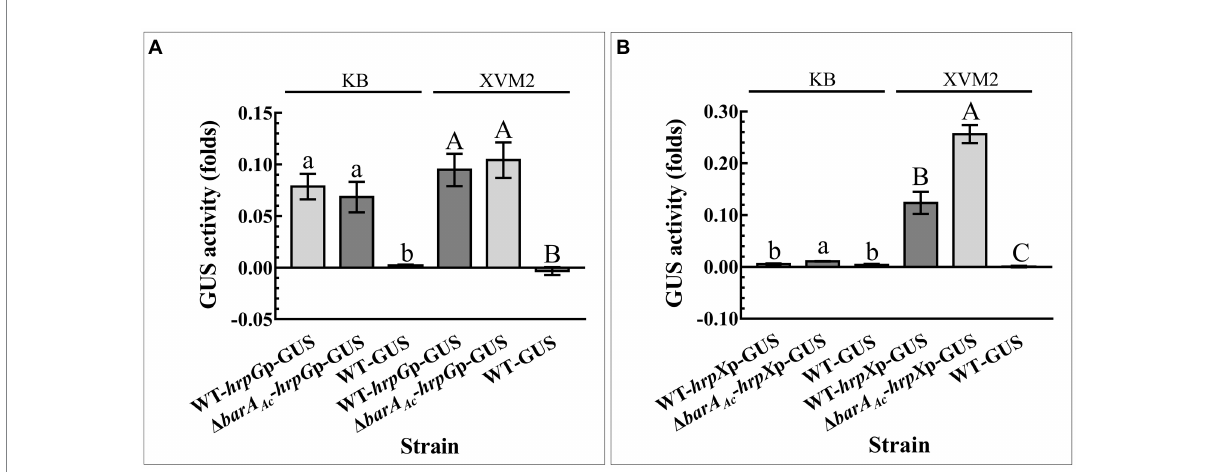
FIGURE 6 The deletion of barA Ac enhanced hrpX promoter activity. The activity of β -Glucuronidase (GUS) was determined by (A) the wild-type strain WT- hrpG p-GUS and the barA Ac deletion mutant strain Δ barA Ac - hrpG p-GUS carrying pBBR-GUS- hrpG p, and (B) WT- hrpX p-GUS and Δ barA Ac - hrpX p- GUS carrying pBBR-GUS- hrpX p in King’s B (KB) medium and XVM2 medium that simulates plant environment. The wild-type strain WT-GUS carrying pBBRNolacGUS was used as a negative control. The error bar represents the standard deviation. Different lowercase and uppercase letters on top of the bar indicate strains with significant differences in the GUS activity in KB and XVM2 medium, respectively (ANOVA, p <